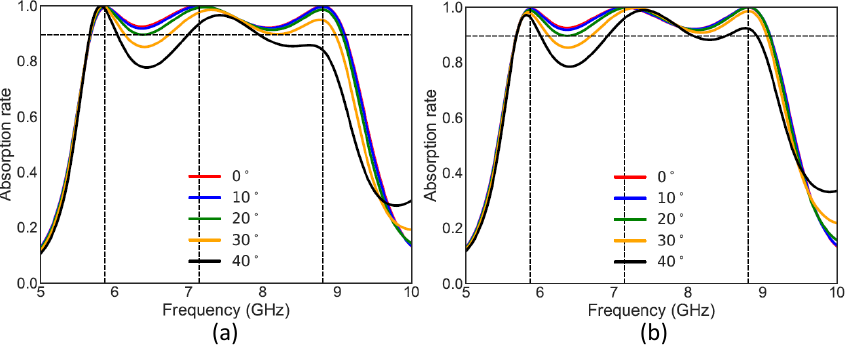
Figure 2. Absorption rate for normal and oblique incidences for ( a ) linearly polarized TE wave and ( b ) linearly polarized TM wave.